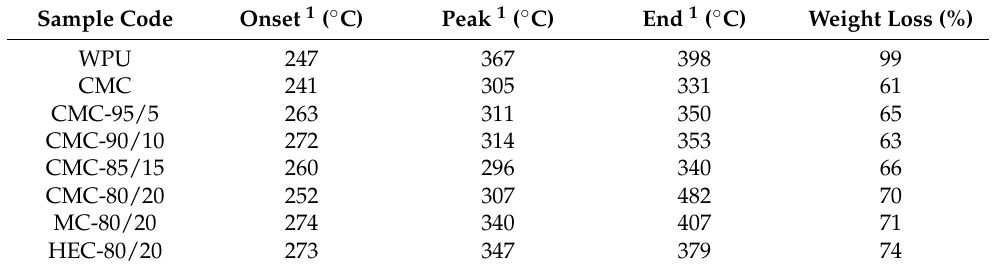
Table 4. TGA analysis parameters of cellulose/WPU composite aerogel with different weight